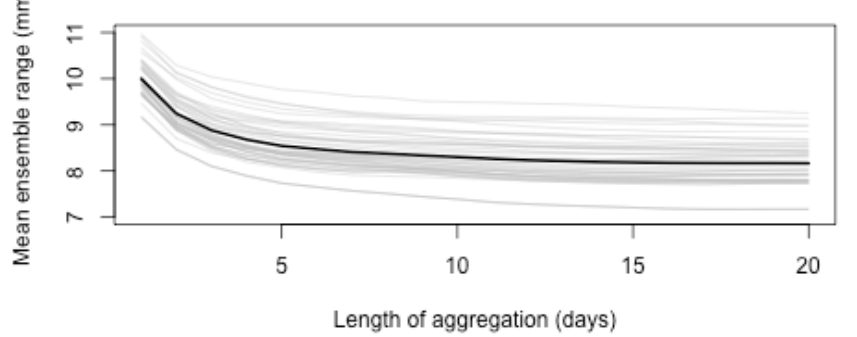
Figure 6. Time length of aggregation plotted against the mean ensemble range for the pixel containing each of the localities shown in Figure 2. The pale grey lines relate to individual time series and the bold line is the mean.